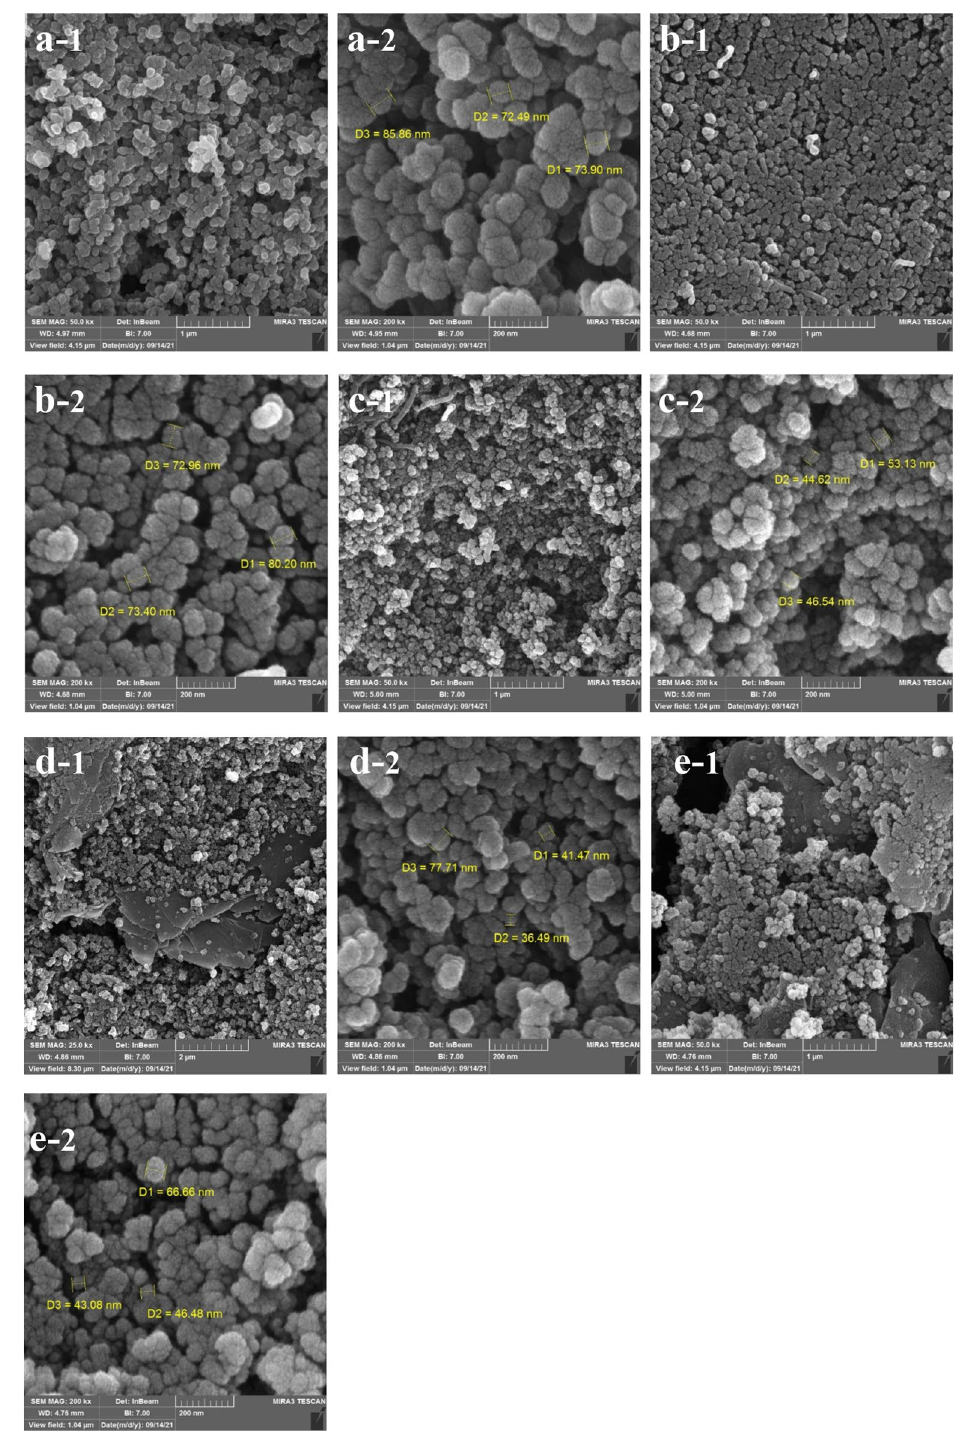
Figure 3. FESEM images of ( a ) UiO-66, ( b ) MWCNT1:UiO1, ( c ) MWCNT2:UiO1, ( d ) Graphene1:UiO1, ( e )